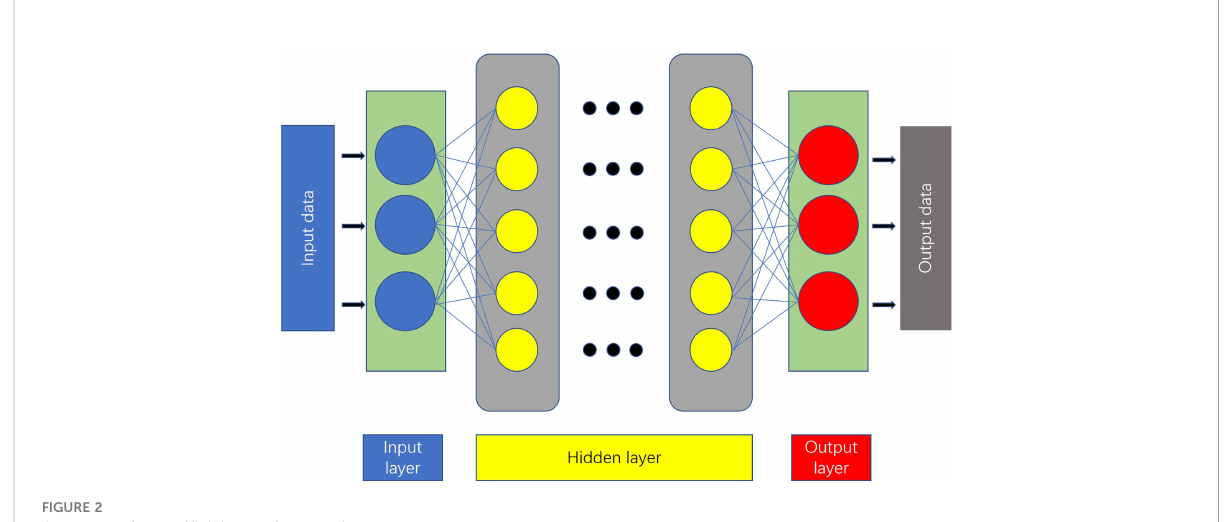
FIGURE 2 Anatomy of an arti fi cial neural